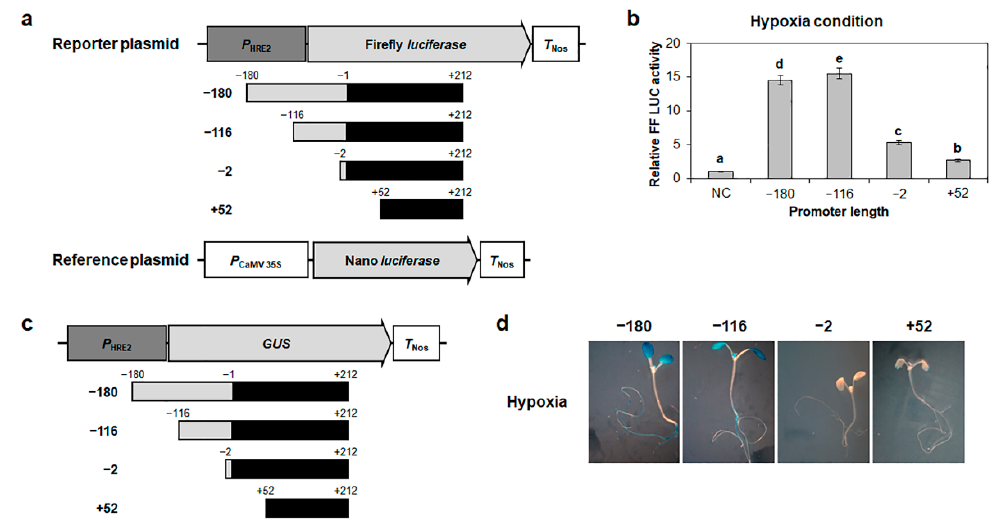
Figure 1. HRE2 promoter deletion analysis under hypoxia. ( a ) Schematic maps of reporter and reference plasmids for HRE2 promoter deletion series analysis. ( b ) Relative firefly luciferase activity in Arabidopsis protoplasts. Transformation efficiency was normalized using Nano luciferase activity. Normalized firefly luciferase activity of negative control was set as 1. Empty reporter plasmid was used for the negative control. Data are shown as means ± S.D. ( n = 3). Different letters display significant differences ( p < 0.05). NC, negative control. ( c ) A schematic map of vector for HRE2 promoter deletion series analysis. ( d ) Histochemical GUS assay of Arabidopsis T 2 transgenic plants carrying the deletion series of HRE2 promoter at 12 days after germination (DAG) under short-day (SD) conditions. GUS activity was observed in at least 15 transgenic plants for each construct; representative staining results are shown here. In ( a , c ), P HRE2 indicates promoter of HRE2